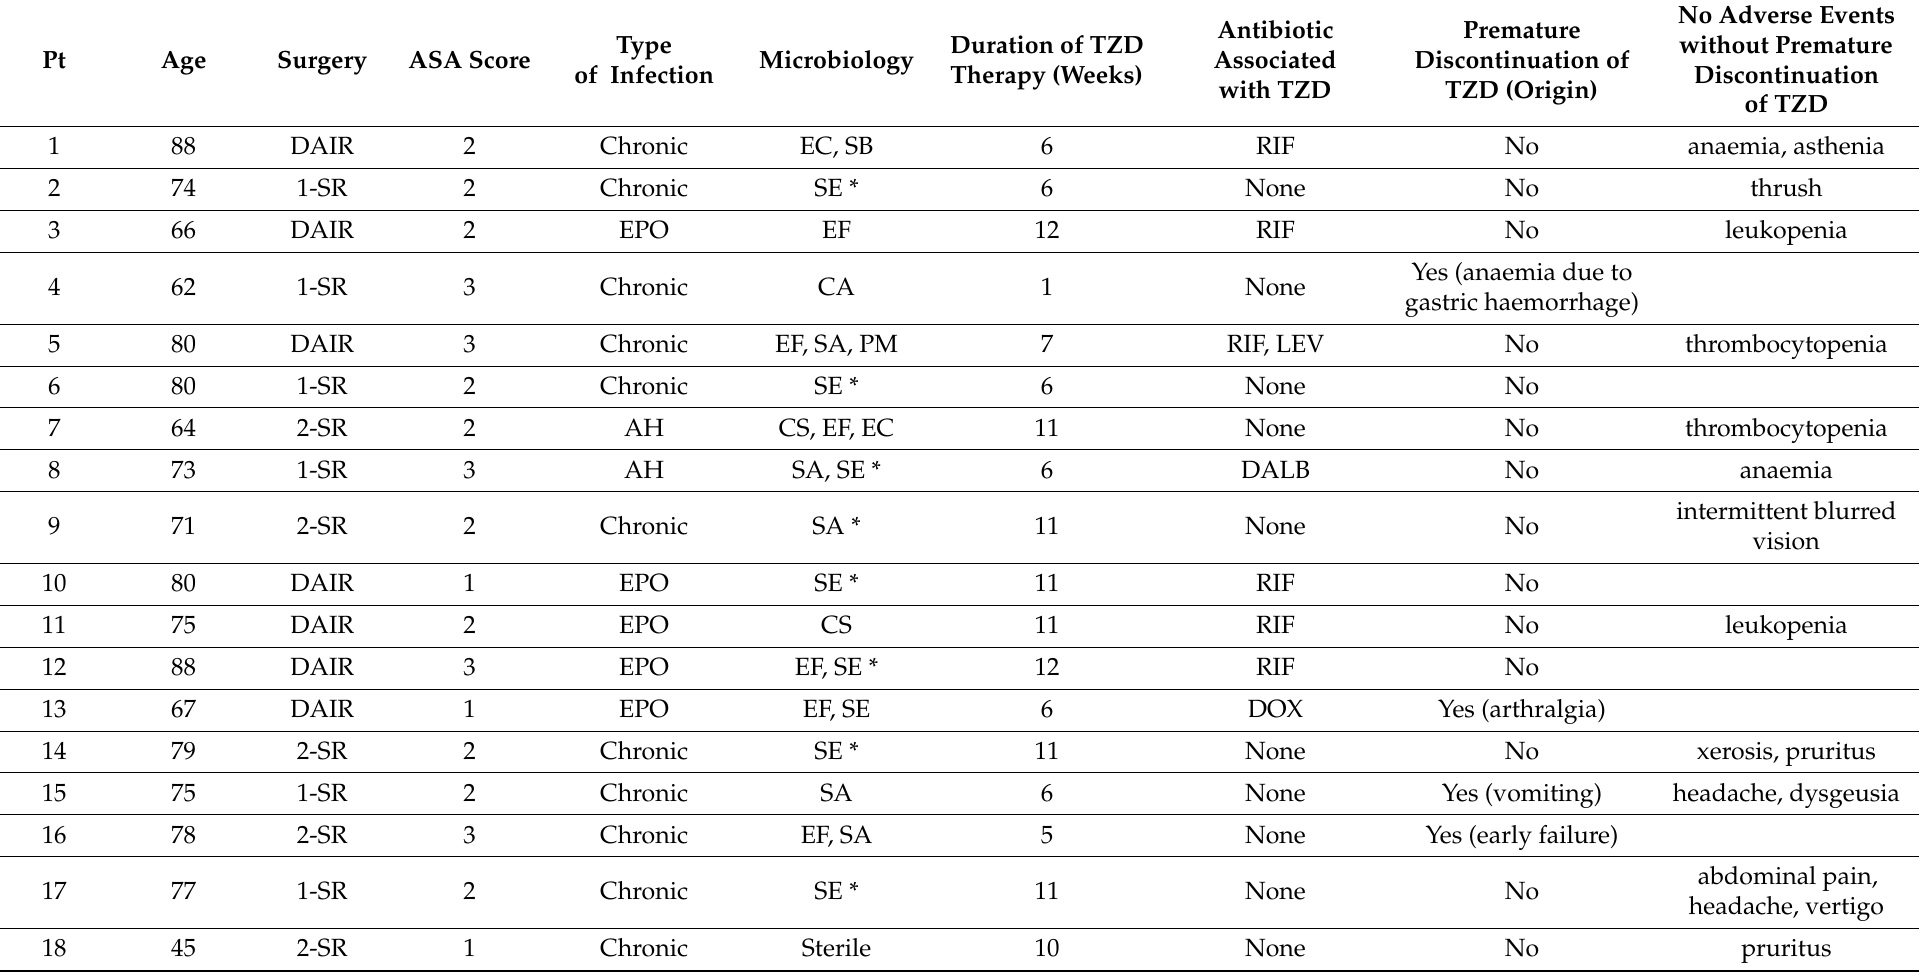
Table A1. Details on tolerance of TZD therapy in 33 patients treated for periprosthetic joint